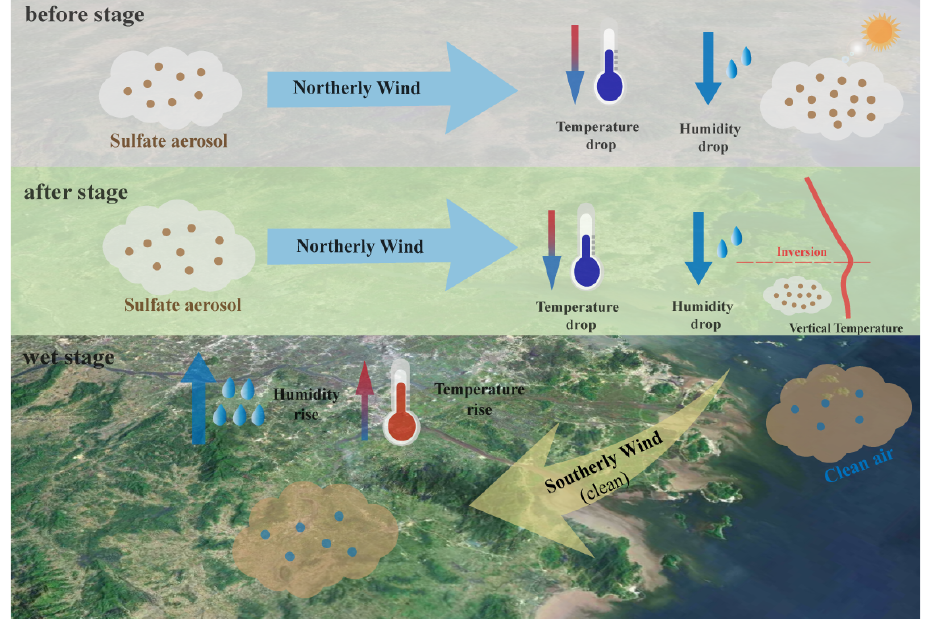
Figure 15. Conceptual model of meteorological and aerosol changes in the before-stage, wet-stage, and after-stage.